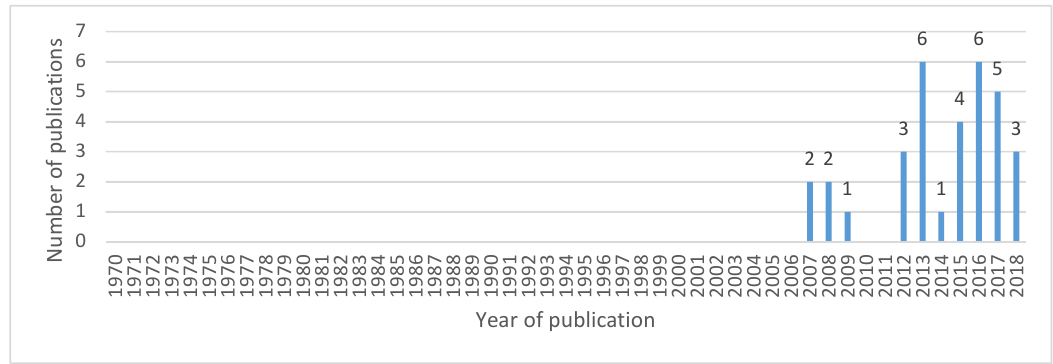
Figure 1. The year of publication of studies included in this review.